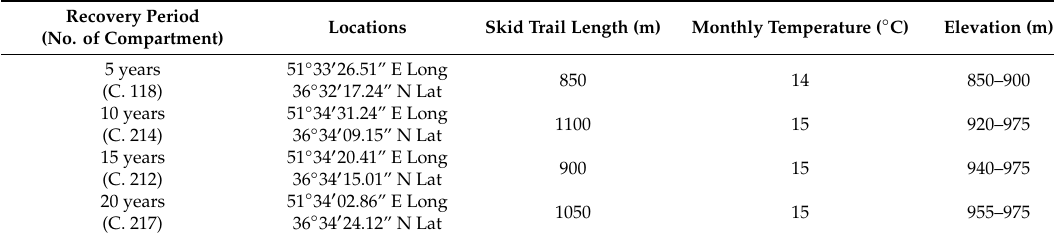
Table 1. Location and description of the study sites. Four skid trails were selected for study in nearby compartments, one in each of the time-since-most-recent-logging classes of 5 years, 10 years, 15 years, and 20